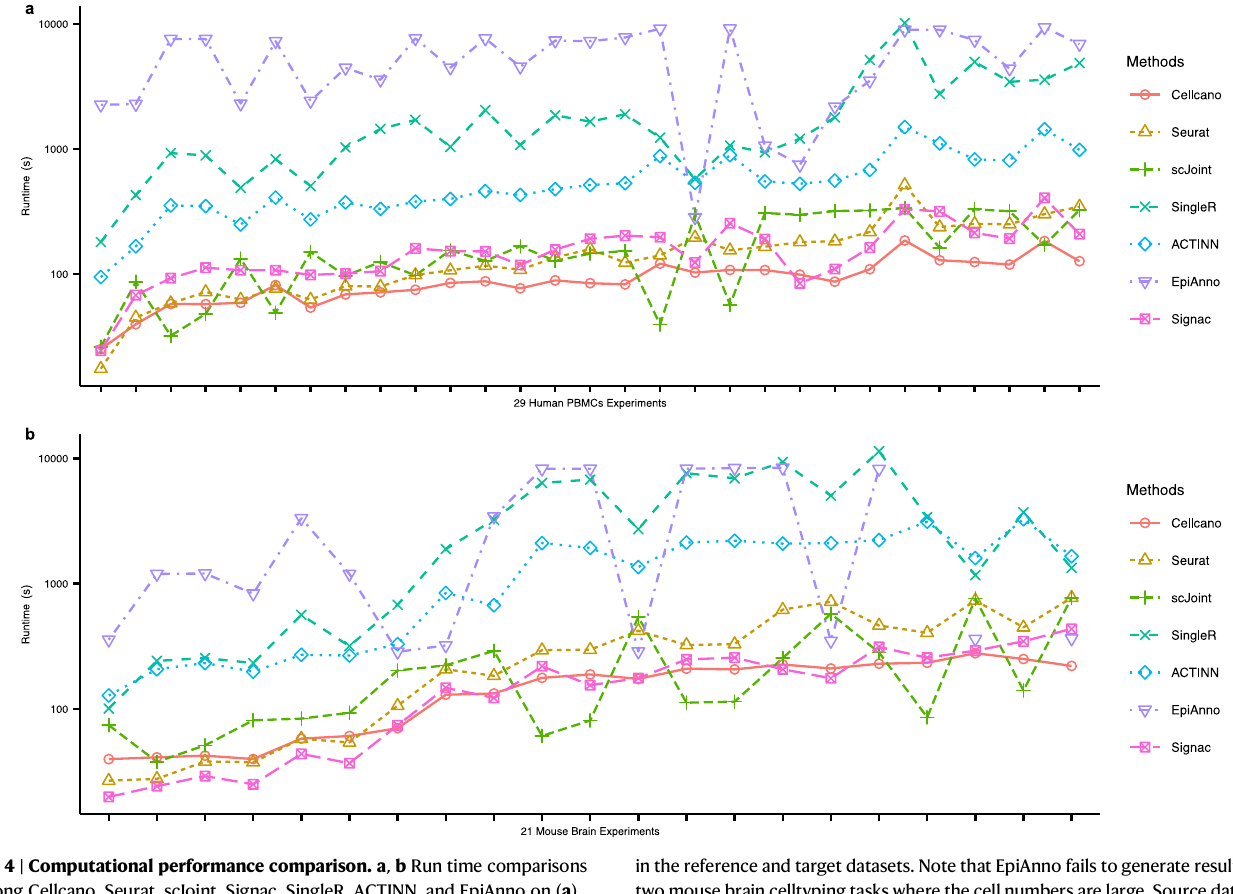
in the referenceand targetdatasets. Note that EpiAnno fails togenerate results for two mouse braincelltypingtaskswhere thecellnumbersarelarge.Source dataare provided as a Source Data fi